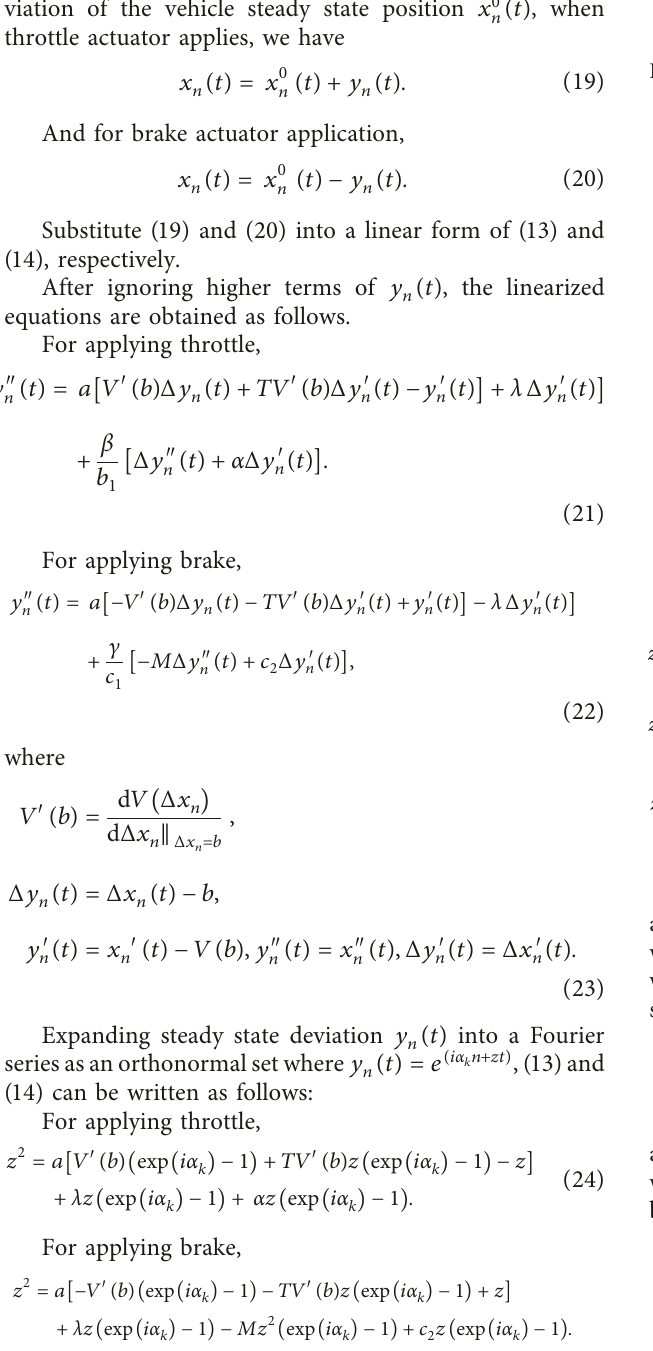
The stability state of traffic f low implementing IH model depends on the value of sensitivity constants of driving model, anticipation time, and derivative of optimal velocity